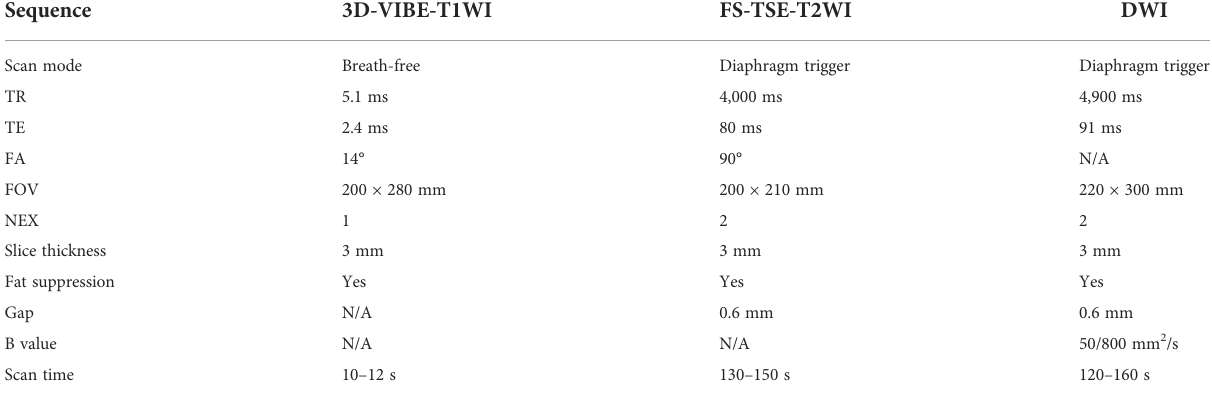
TABLE 1 MRI sequences and